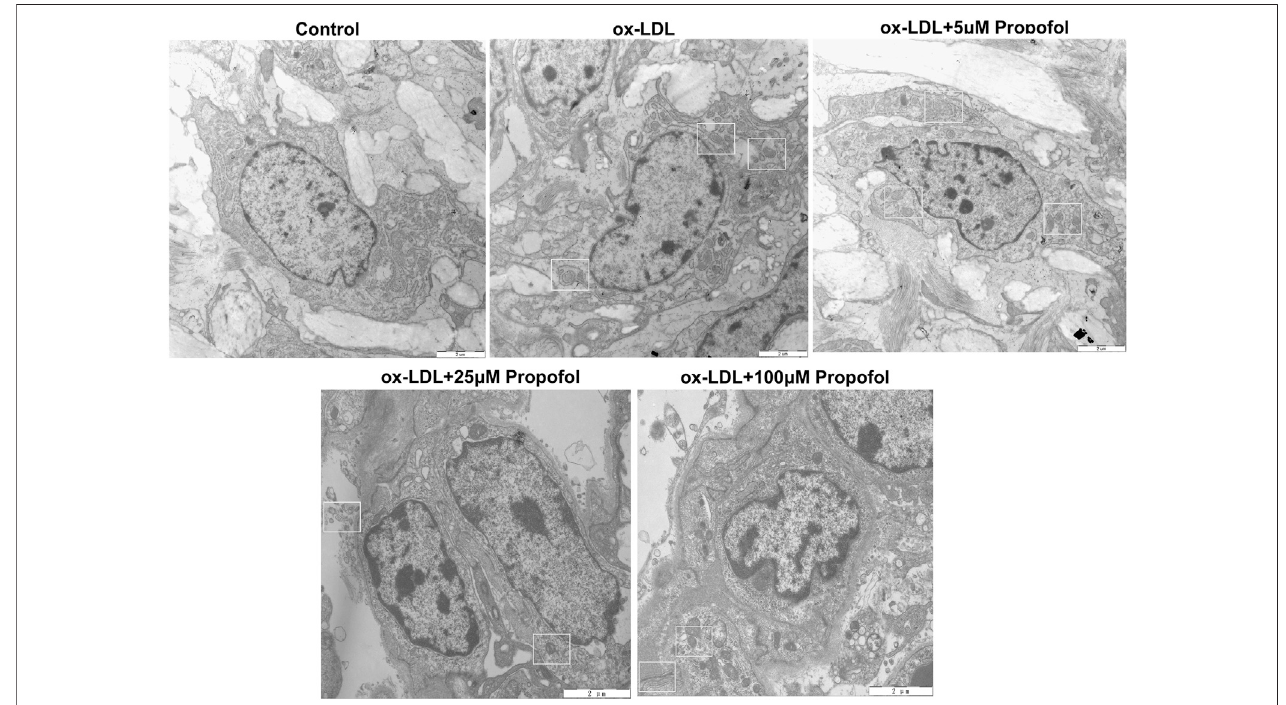
FIGURE 3 | Transmission electron microscope for the autophagosomes in 100 μ g/mL ox-LDL-exposed HUVECs treated with 0, 5, 25 and 100 ° μ M Propofol (Bar (cid:2) 2 ° μ m). Autophagosomes are